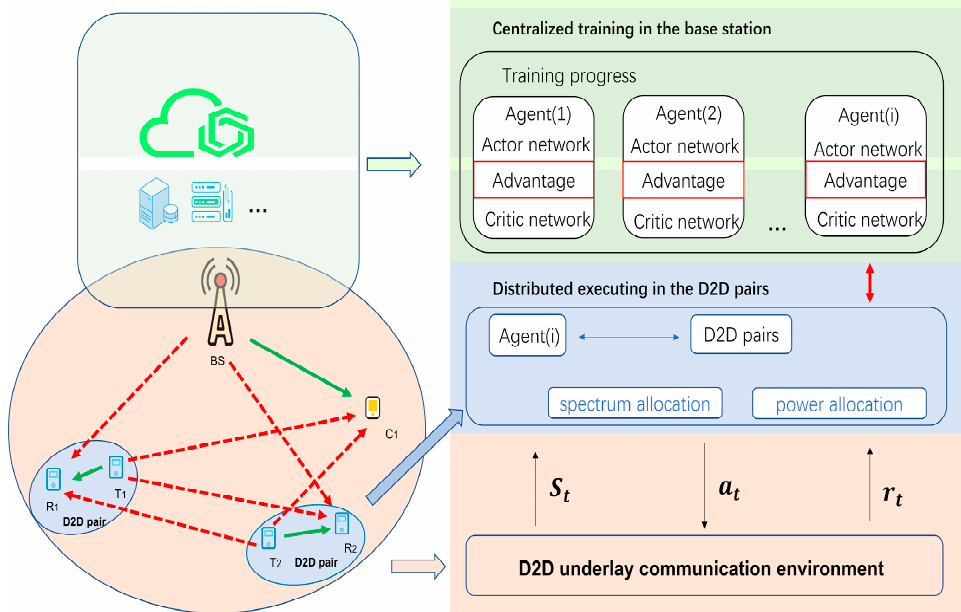
Figure 2. Model of A2C-based multi-agent D2D communication system. as follows: